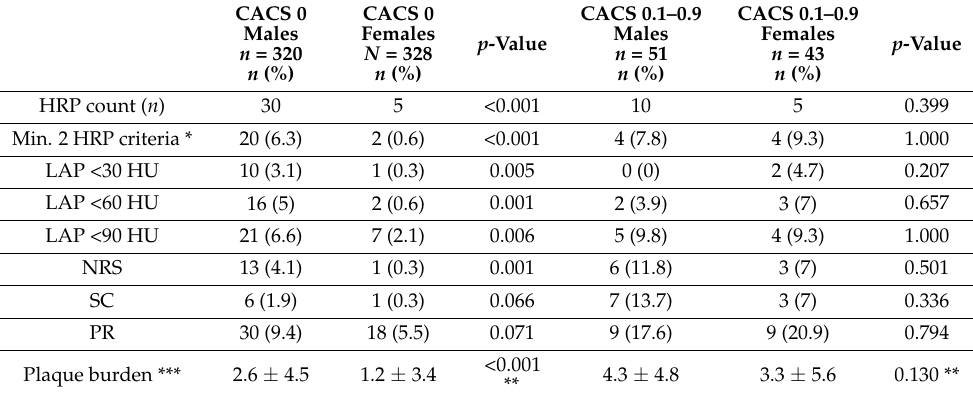
Table 5. High-risk plaque (HRP) criteria and plaque burden by coronary CTA after propensity score matching ( n = 742).